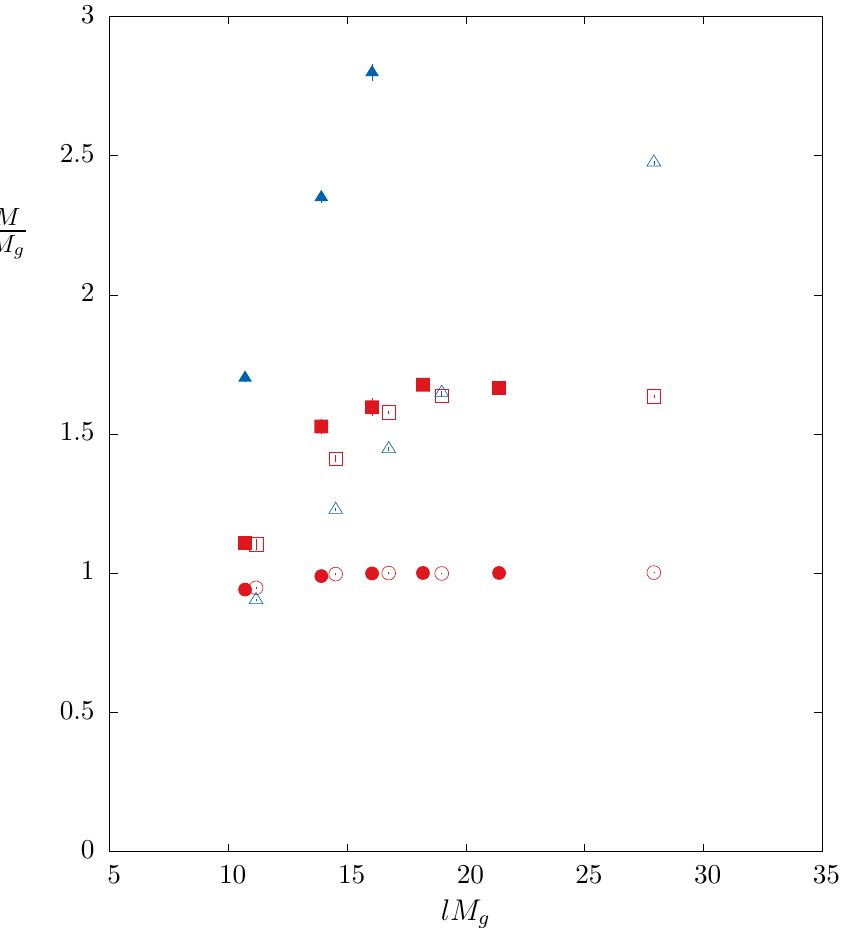
Figure 30 . Lightest scalar ( (cid:14) ) and tensor ( (cid:3) ) glueballs in SU(2) on various spatial volumes, l 2 , all in units of the in(cid:12)nite volume mass gap M g . And same for SO(4) ( (cid:15) , (cid:4) respectively). Also shown is twice the fundamental (cid:13)ux loop mass in SU(2) ( 4 ) and SO(4) ( 4 ). using SO(6) intead of SO(4) would have been elegant, but since (cid:27) SO6